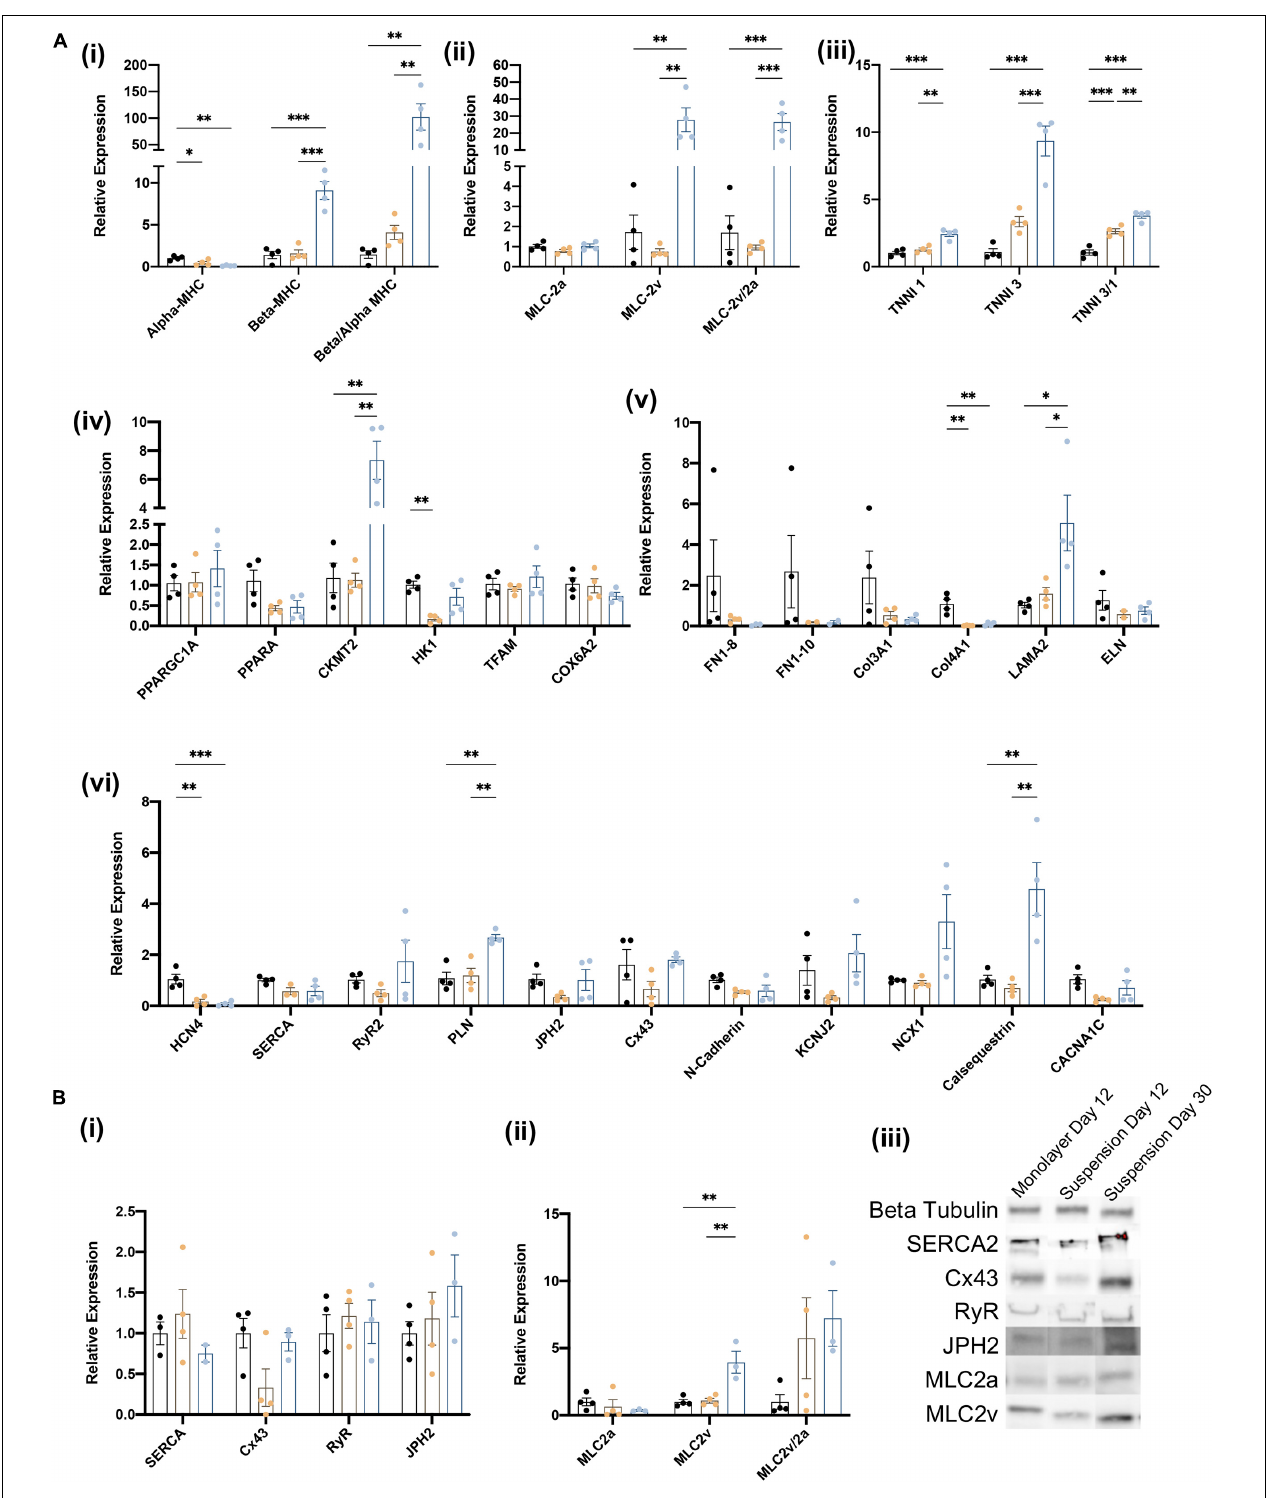
FIGURE 5 | Characterization of iCMs produced in suspension vs. monolayer for biochemical markers of maturation. (A) RT-qPCR analysis of relative gene expression normalized to GAPDH and monolayer expression on day 12 and 30 for (i) myosin heavy chain isoforms, (ii) myosin light chain isoforms, (iii) troponin I isoforms, (iv) metabolic activity, (v) structural organization, and (vi) calcium handling genes. Groups are as follows, black: monolayer CMs at day 12, blue: suspension CMs at day 12, and yellow: suspension CMs at day 30. (B) Western blot quantification of proteins related to (i) CM maturity and (ii) myosin light chain isoforms. (iii) Blot image for selected samples. ∗ p < 0.05; ∗∗ p < 0.01; ∗∗∗ p < 0.001. ( n = 4).